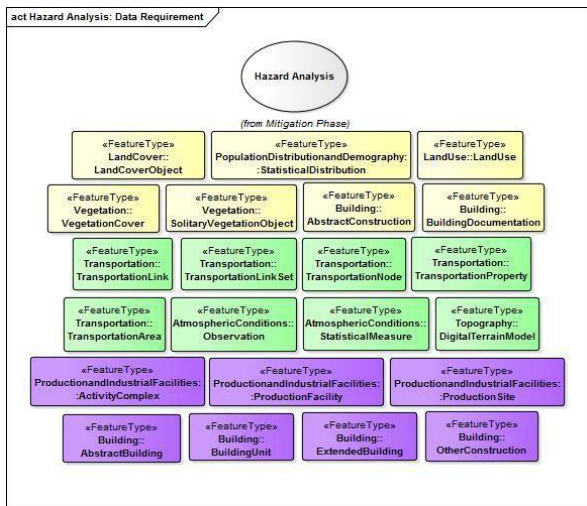
Figure 9: Geo-information requirement diagram of “hazard analysis” process